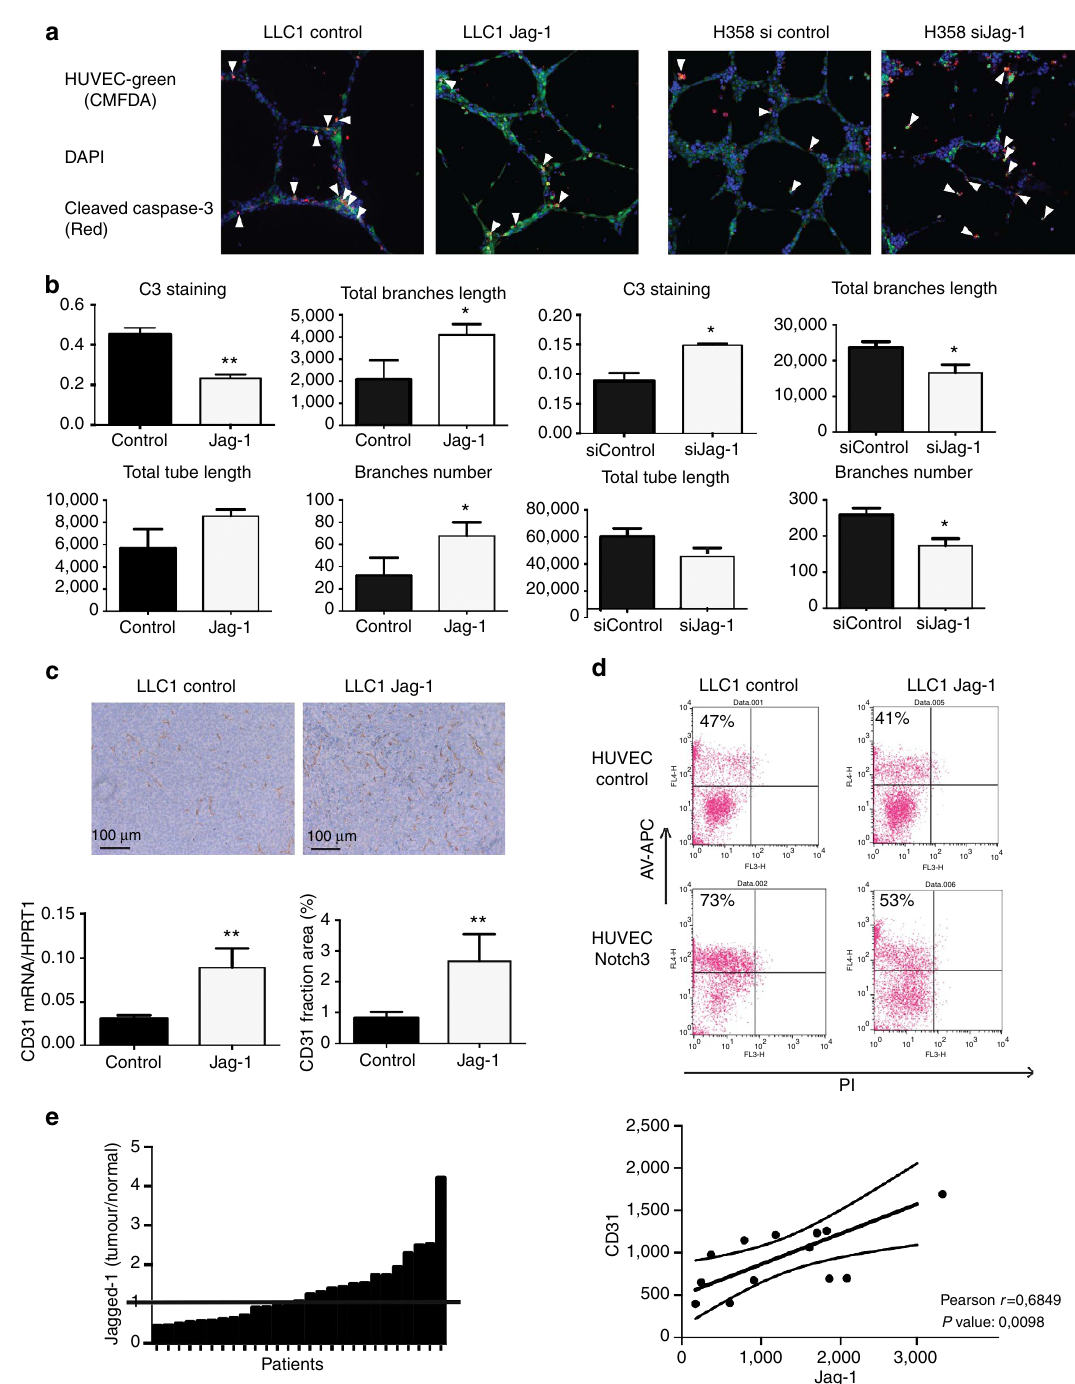
Figure 4 | Jag-1 rescues Notch3-induced endothelial cell death. ( a ) HUVEC were stained with the CellTRacker green CMFDA. Cleaved-caspase-3 staining of HUVEC co-cultured with 1) LLC1 expressing or not Jag-1 (LLC1-Jag-1 and LLC1-Control, respectively) or 2) H358 cells transfected with a siRNA control (sicontrol) or a siRNA targeting Jag-1 (siJag-1). Co-cultures were maintained in matrigel for 9h before being fixed and stained. Images are representative of three independent experiments, each performed in triplicate. ( b ) Quantification of HUVEC networks presented in a ( n ¼ 3, means ± s.d., t -test was applied). Jag-1 expression was verified on western blot before the cells were added to HUVEC in